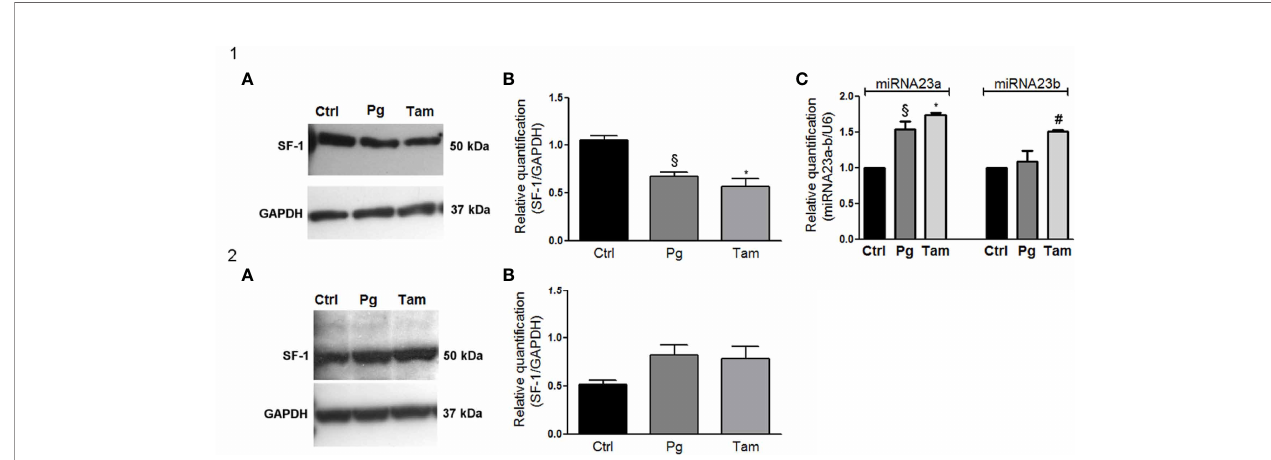
FIGURE 7 | Tamoxifen and Pg reduced the SF-1 expression in NCI-H295R cell line. (1A) Representative western blot of SF-1 expression after NCI-H295R tamoxifen IC 50 and Pg IC 50 4 days treatment. (1B) Densitometric analysis of SF-1 expression after NCI-H295R drug treatment. Data are expressed as normalized values SF-1/GAPDH and are the mean of three independent experiments. *P < 0.0001 vs ctrl; §P < 0.001 vs ctrl. (1C) NCI-H295R were treated with tamoxifen IC 50 or Pg IC 50 for 4 days and then miRNA23a/b expression was investigated. Data are expressed as normalized values on internal control U6 and are the mean of three independent experiments. *P < 0.0001 vs ctrl; § P < 0.001 vs ctrl; #P < 0.01 vs ctrl. (2A) Representative western blot of SF-1 expression after MUC-1 tamoxifen IC 50 and Pg IC 50 5 days treatment. (2B) Densitometric analysis of SF-1 expression after MUC-1 drug treatment. Data are expressed as normalized values SF-1/GAPDH and are the mean of three independent